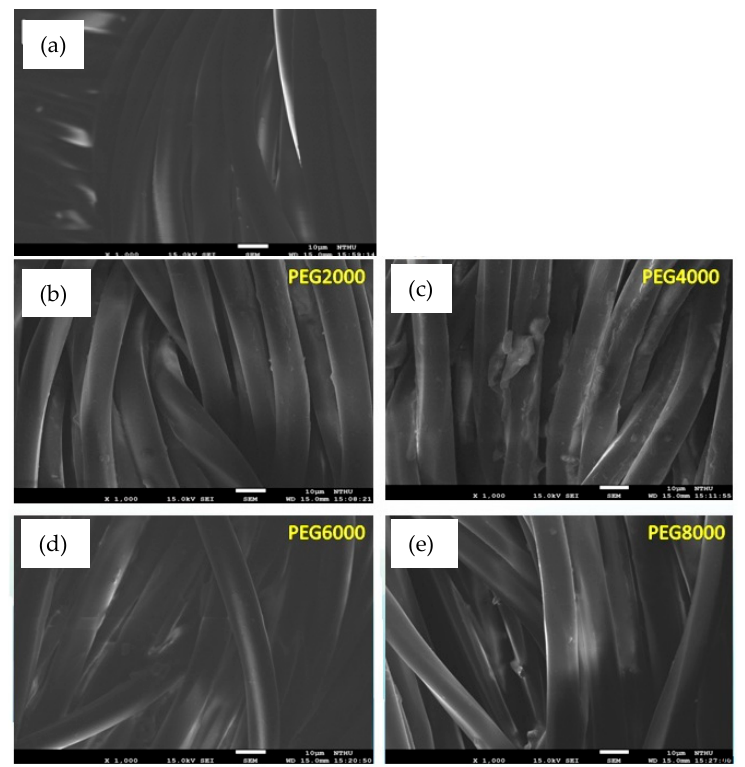
Figure 2. SEM (Scanning Electron Microscopy) images of poly(lactic acid) fabric uncoated and coated with chitosan/siloxane polyesters, magnified 1000 times; ( a ) uncoated; ( b ) coated Chitosan/siloxane polyesters with PEG 2000; ( c ) coated Chitosan/siloxane polyesters with PEG 4000; ( d ) coated Chitosan/siloxane polyesters with PEG 6000; ( e ) coated Chitosan/siloxane polyesters with PEG 8000.